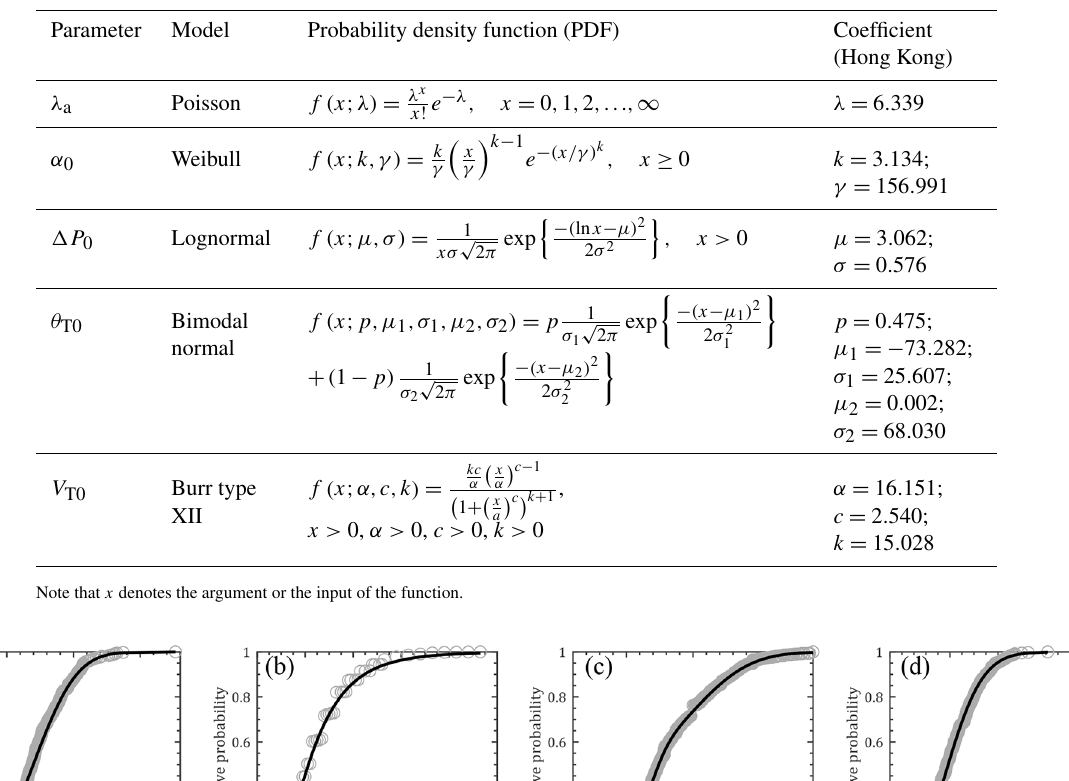
Table 1. Distribution models and coefficients for TC track genesis parameters.